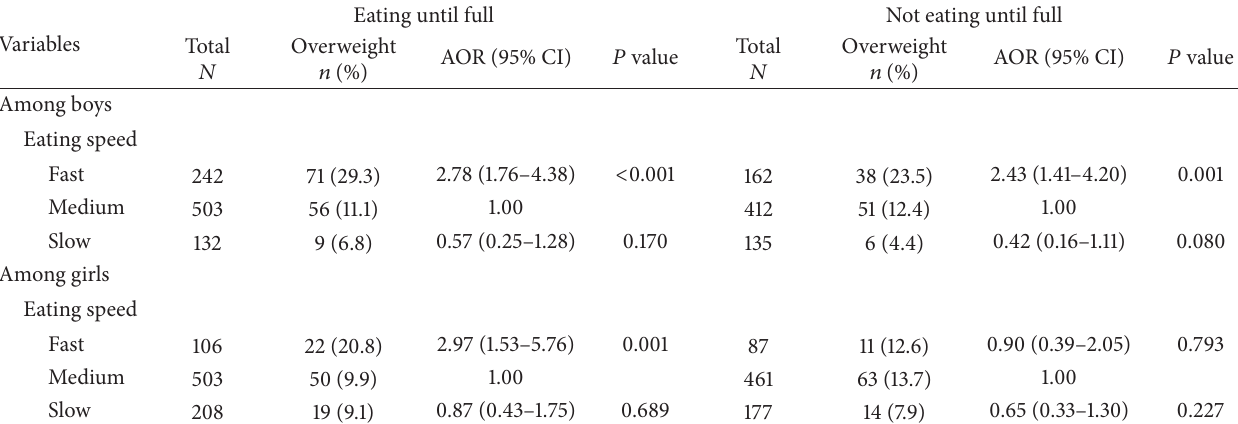
Table 4: Adjusted odds ratios of eating speed for being overweight by eating until full or